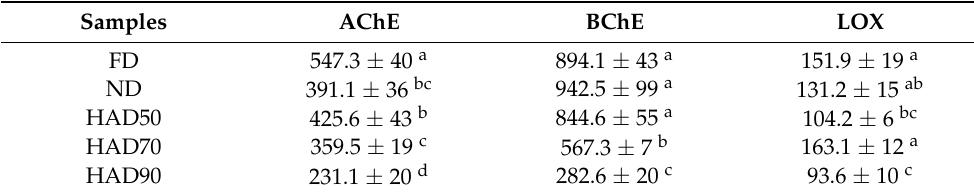
Table 1. AChE, BChE and LOX inhibitory activity levels (IC 50 µ g/mL) of thinned peach extracts obtained using